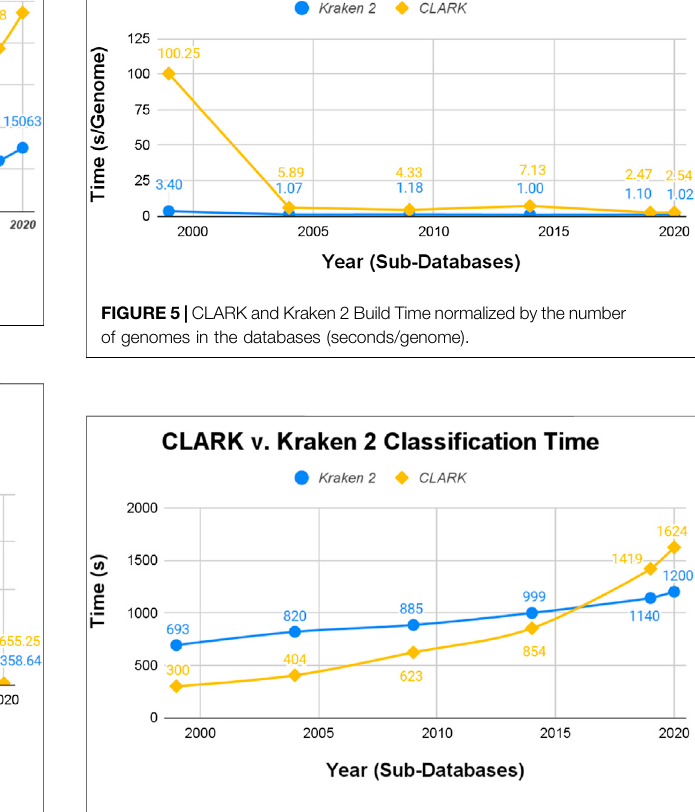
FIGURE 6 | CLARK and Kraken 2 raw Classi fi cation Time